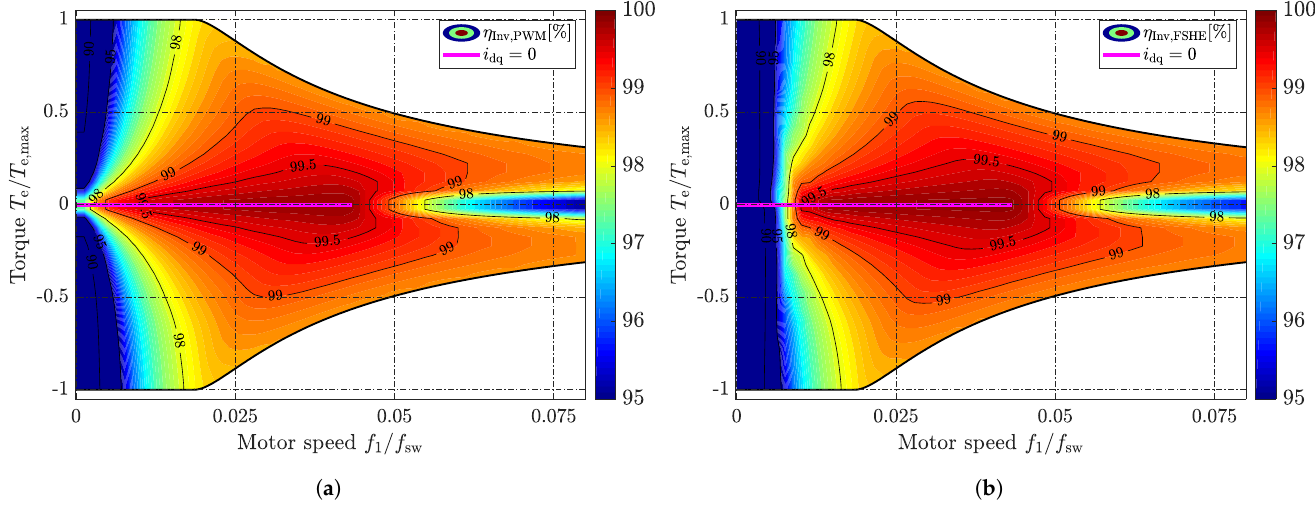
Figure 12. Simulated inverter efficiency η Inv for the entire drivetrain operating range for ( a ) multilevel PWM and ( b ) FSHE.